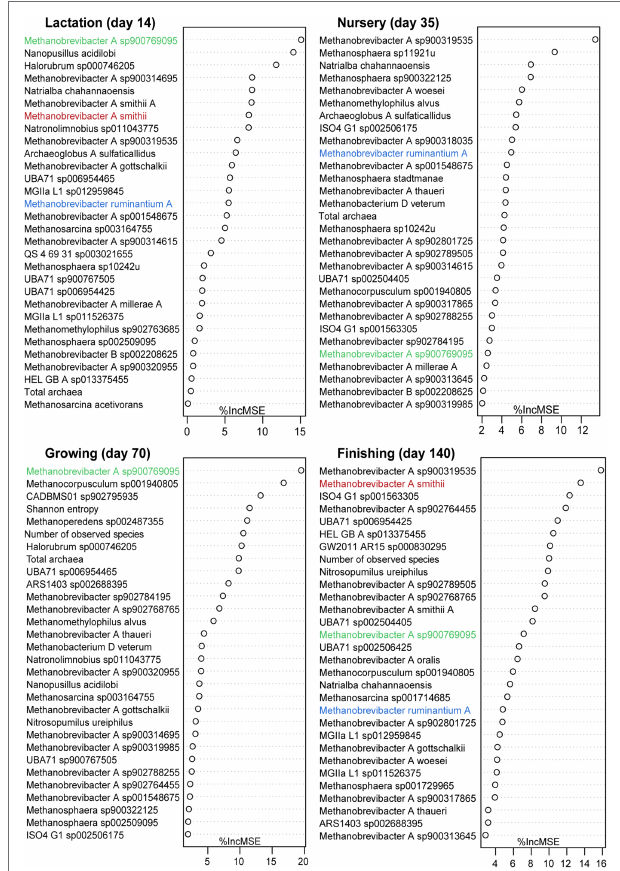
FIGURE 5 | Growth performance-related archaeal species at different growth stages. Top 30 most important bodyweight-related archaeal species on days 14, 35, 70, and 140 were identified using the random forest regression algorithm in R. The most abundant species on different days are highlighted with different